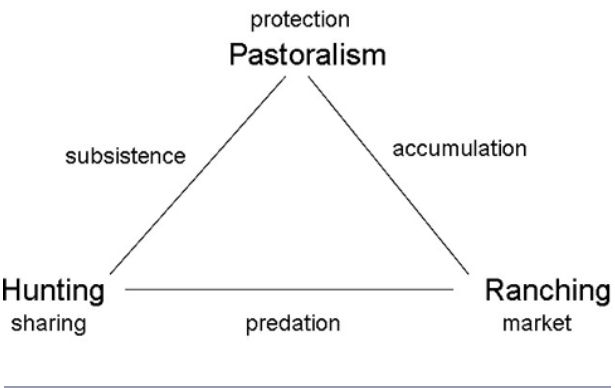
Fig. 1 . Human–Rangifer modes of production. Source: Ingold